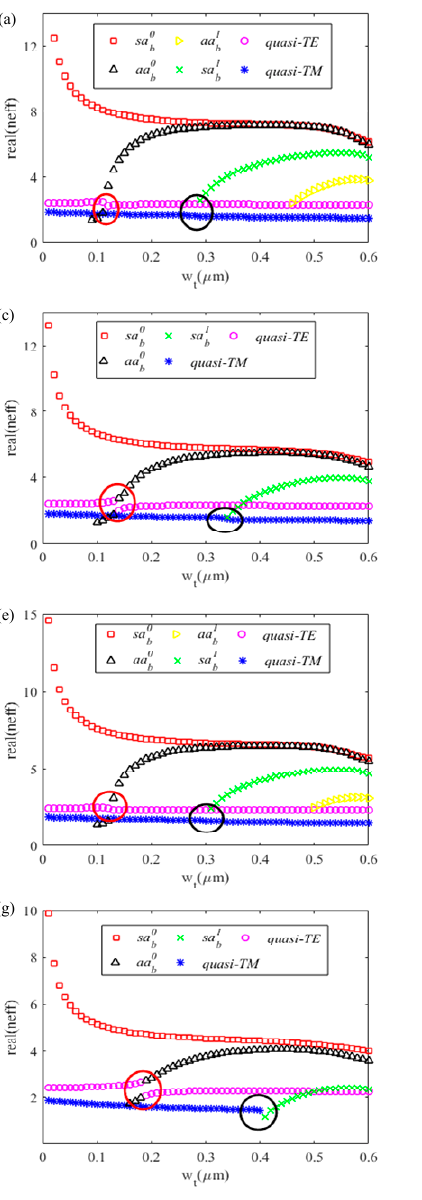
Figure 8. ( a , c , e , g ) Real parts of the effective indices versus w t ; ( b , d , f , h ) imaginary parts of the effective indices versus w t . ( a , b ) Au, h m = 5 nm; ( c , d ) Au, h m = 7 nm; ( e , f ) Al, h m = 2 nm; ( g , h ) Al, h m = 4 nm. Other parameters: λ = 2 µm, w si = 600 nm, h si = 340 nm.